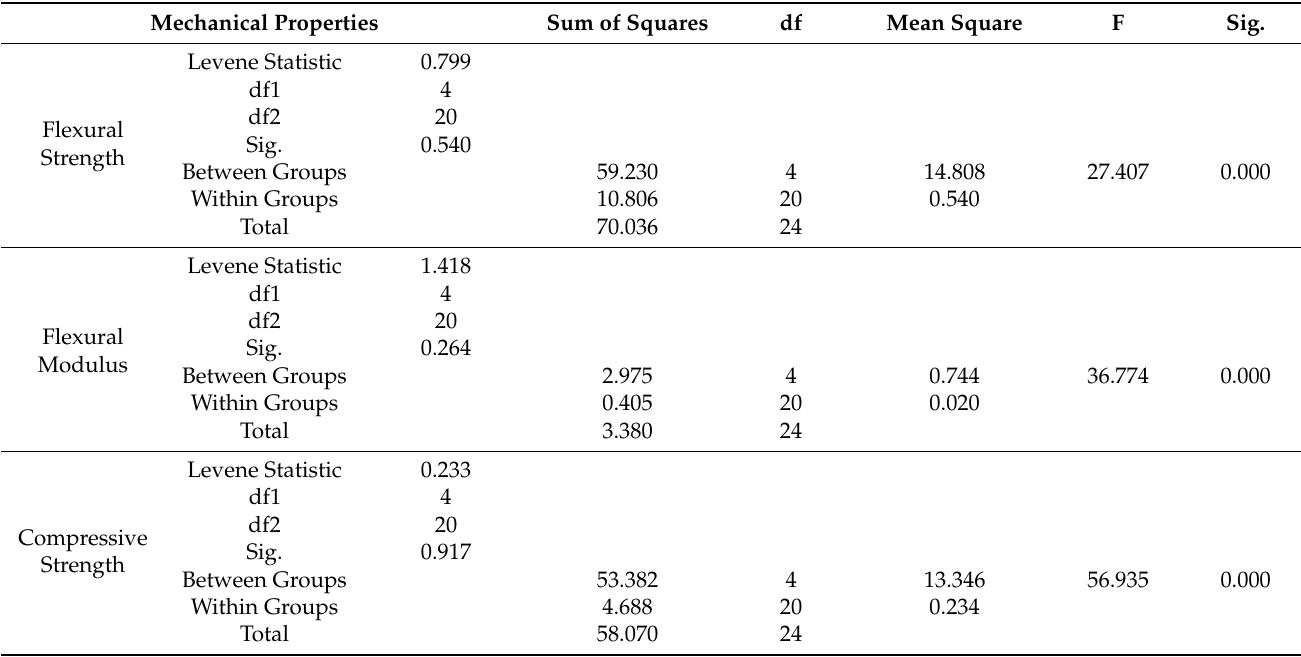
Table A2. Analysis of variance for mechanical properties with various PP